Question: Write a single sentence explaining what this figure depicts.
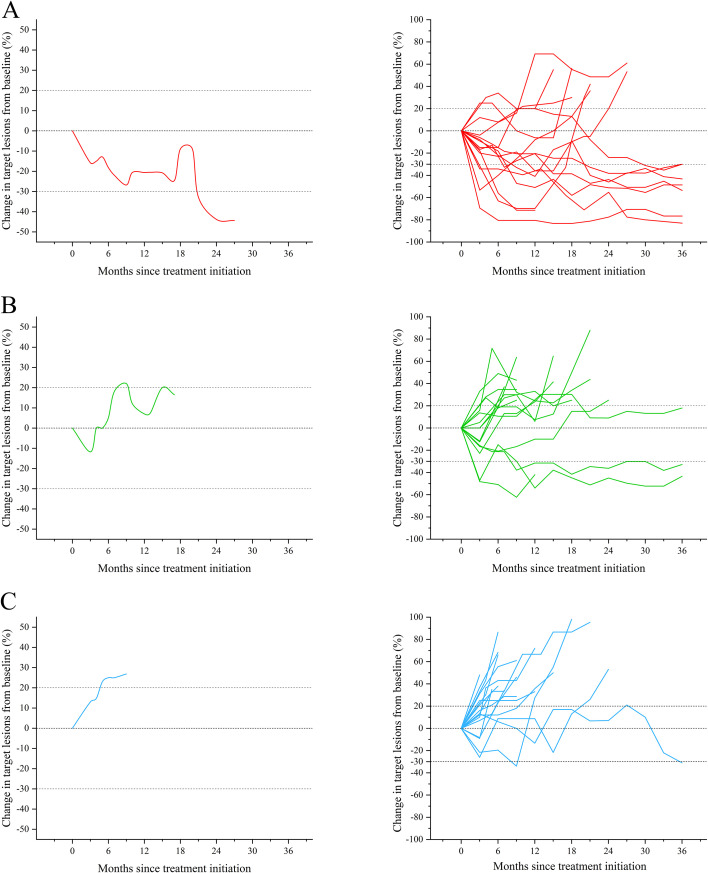
Answer: Change in target lesions from baseline based on early CRP kinetics. (A) for CRP flare-responders, (B) for CRP responders, and (C) for CRP non-responders: median target lesions change from baseline in per cent is shown in the left panel; the target lesions changes of the individual patients are shown in the right panel. Each group will cease recording the overall percentage change in target lesions once the number of follow-up participants reaches half of the initial count, though the percentage change for individual target lesions will continue to be recorded.